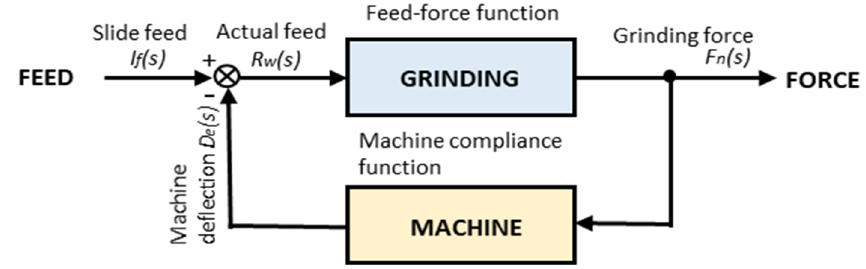
Figure 1. Generalized grinding model.